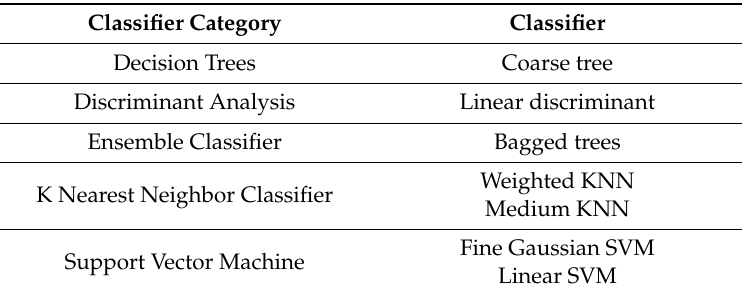
Table 2. Different types of classifiers tested.